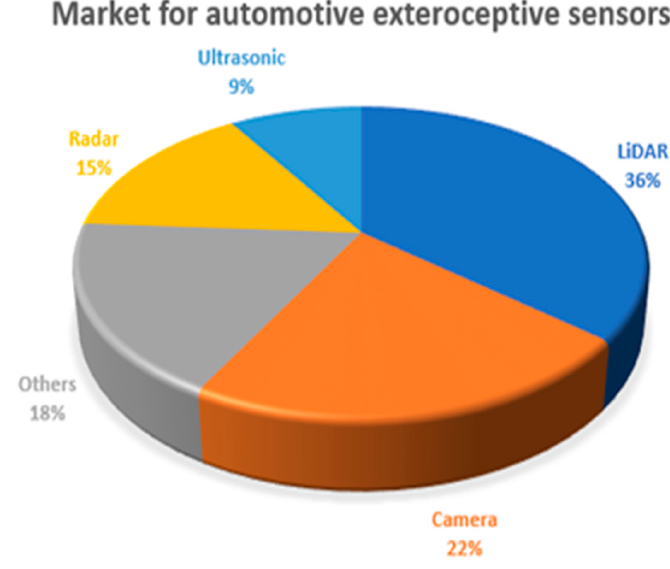
Figure 1. The prediction of automotive sensors market growth (compound annual growth rate (CAGR), 2017–2022) on exteroceptive sensors.